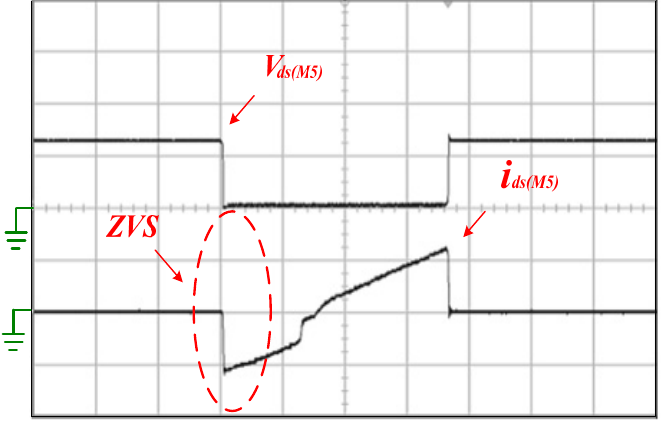
: 20 V/div; i : 5 A/div; time: 2 ds ds